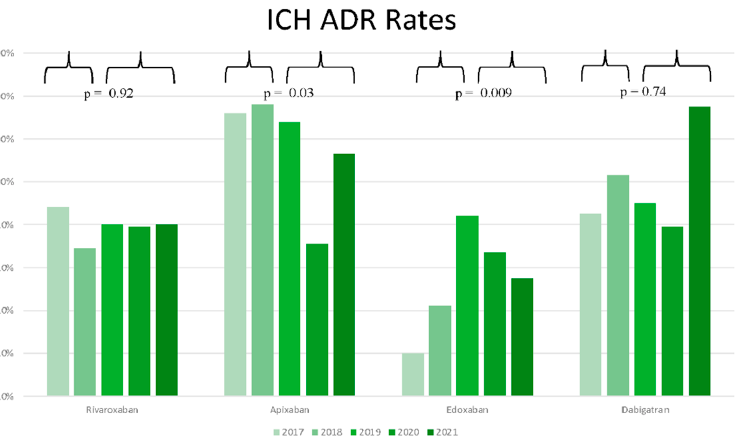
Figure 3. Rates of ICH ADR relative to total ADR for each molecule for all study years. During the period from 2017 to 2021, the use of dabigatran was related to 947 GI ADR (Table 1), accounting for almost 36% of total GI ADR ( n = 2633), while rivaroxaban, edoxaban, and apixaban were associated with 25.9%, 22.9% and 15.2% of total GI ADR, respectively. There was no overall statistically significant difference in the rate of GI ADR during the period 2017–2021 ( p -value = 0.27 for rivaroxaban, p -value = 0.43 for apixaban, p -value = 0.39 for edoxaban, and p -value = 0.29 for dabigatran as shown in Figure S3). No statistically significant difference was found when comparing 2019–2021 GI ADR rates with 2017–2018 rates for each molecule ( p -value = 0.75 for rivaroxaban, p -value = 0.83 for apixaban, p -value = 0.25 for edoxaban, and p -value = 0.14 for dabigatran, as shown in Figure 4). When comparing GI ADR rates for the period 2019–2021, no differences were found among rivaroxaban and apixaban ( p -value = 0.35) or rivaroxaban and edoxaban ( p -value = 0.15). Dabigatran was associated with higher GI ADR rates as compared with the other molecules ( p -value < 0.001 for rivaroxaban, p -value < 0.001 for apixaban, p -value < 0.001 for edoxaban). Apixaban and Rivaroxaban were associated with a RI of GI ADR < 1 during the whole period from 2017 to 2021, with a RI for the year 2021 of 0.7 and 0.76, respectively. Conversely, edoxaban and dabigatran presented a RI for GI ADR >1, with a RI for the year 2021 of 1.3 and 1.7, respectively (Figure 2).